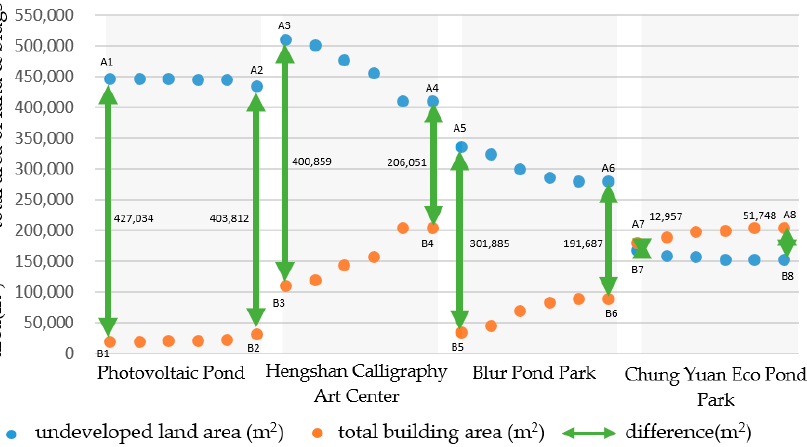
Figure 15. The evolving direction of pond development from the initial stage, converging, and intersection to the switching position.